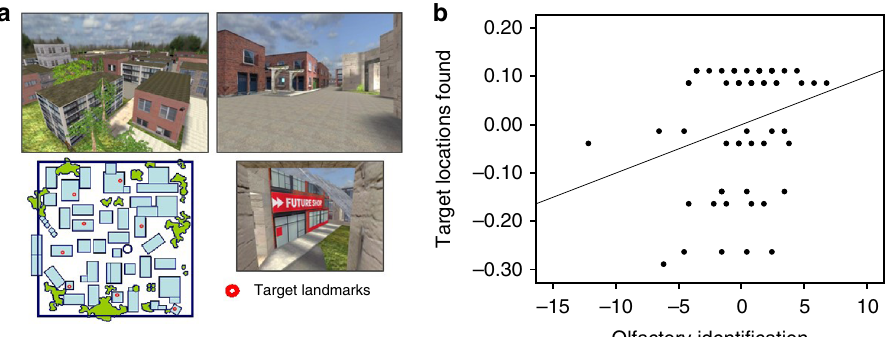
Fig. 1 Olfactory identi fi cation correlates with way fi nding ability. a The way fi nding task involves learning the location of eight key landmarks in a virtual town. Participants fi rst explore the town for at least 20 min, until they have visited every street and alley and passed by each key landmark twice. Then, in eight probe trials, participants are placed in front of one landmark and are asked to fi nd the most direct route to another given landmark. b We found olfactory identi fi cation to be positively correlated with the percentage of target locations found ( r = 0.26, Bootstrap BCa 95% CI [0.06,